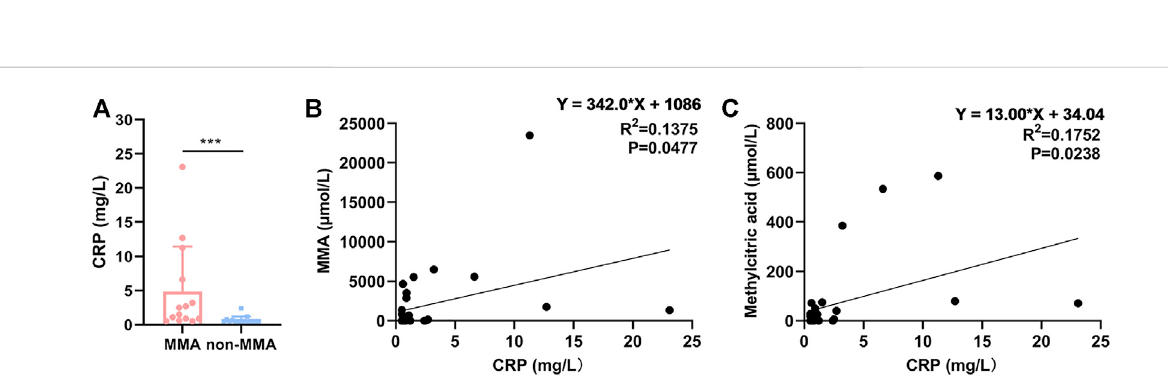
Figure 5. APOE is not only a target of itself but also a target protein of other APO family members. TPP1, which is signi fi cantly downregulated in MMA patients, is mainly a target protein of BCAR1, while the downregulated protein of TUBB interacts with multiple DEPs at the same time.